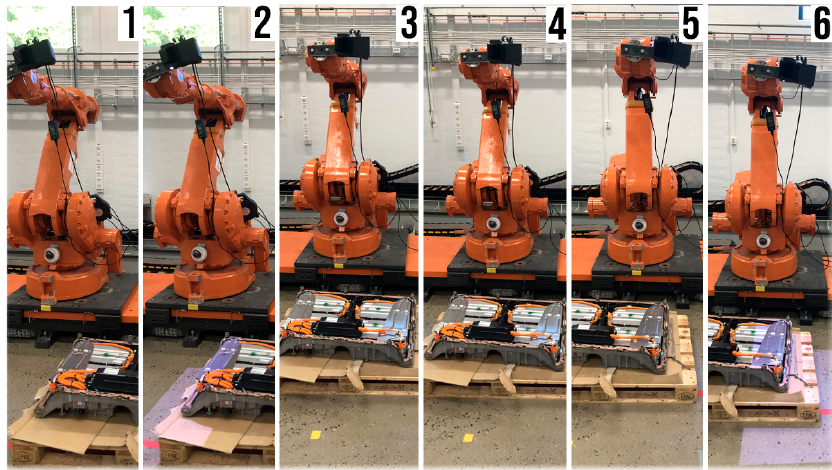
Figure 11. Image capturing